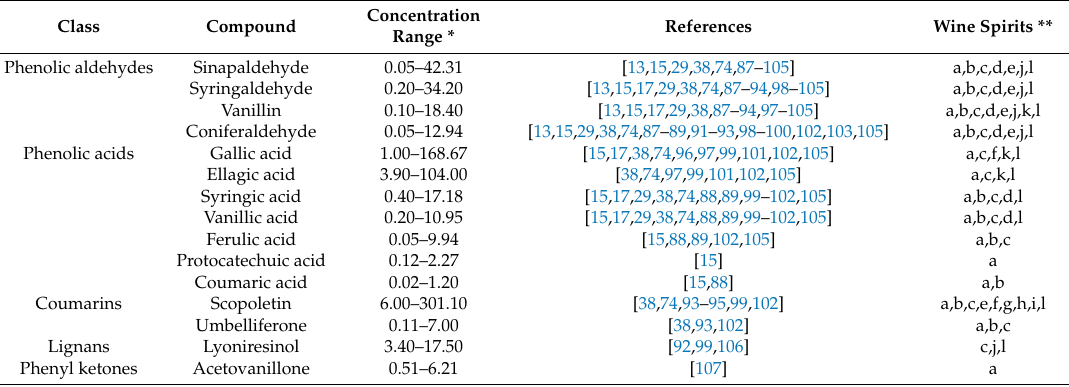
Table 1. Low molecular weight phenolic compounds found in aged wine spirits.